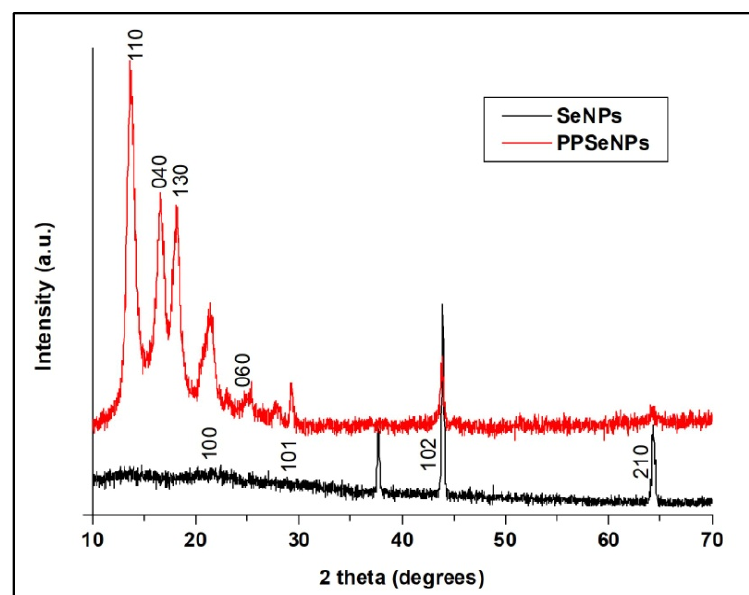
Figure 2. XRD patterns of the prepared SeNPs and SeNPs-PP fabric.